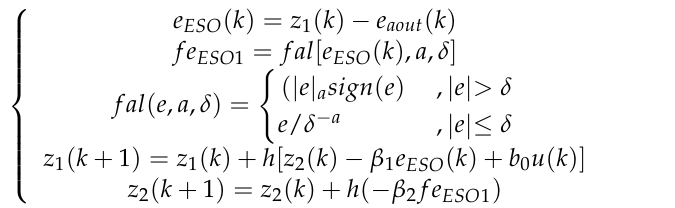
Figure 4. The structure of the ADRC controller.